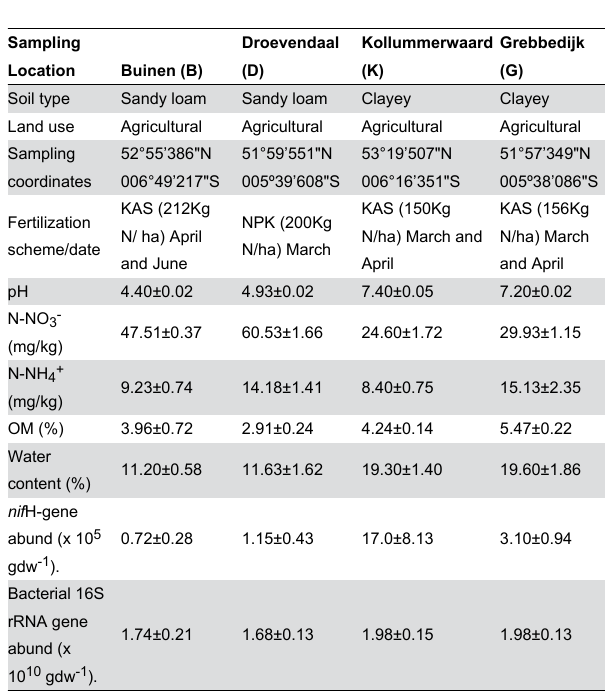
Table 1. Sampling locations, environmental and biological